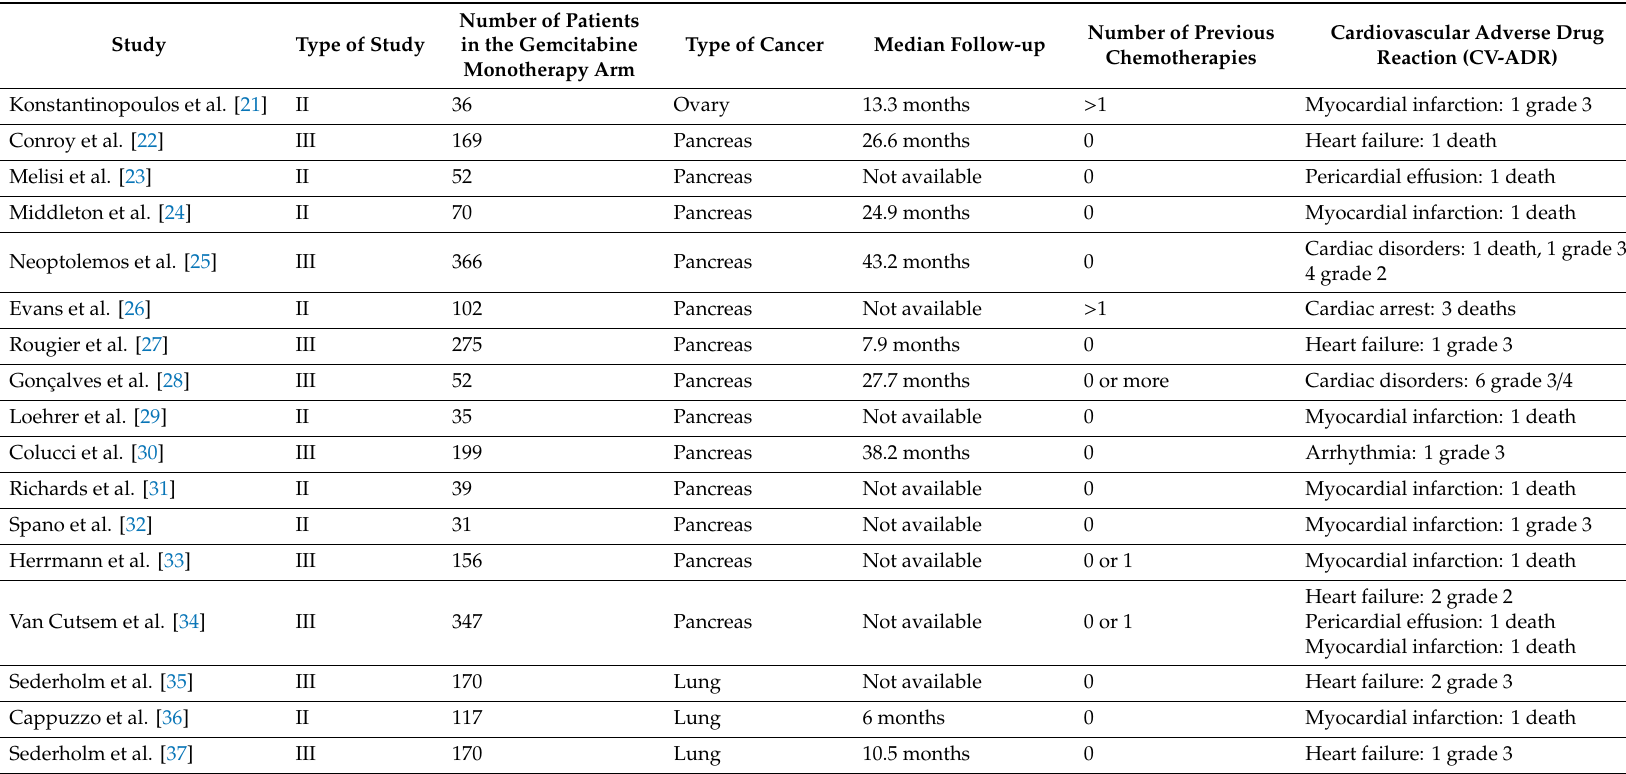
Table 2. Cardiovascular adverse drug reactions in randomized clinical trials evaluating gemcitabine in monotherapy with at least one report for cardiovascular adverse-drug-reactions